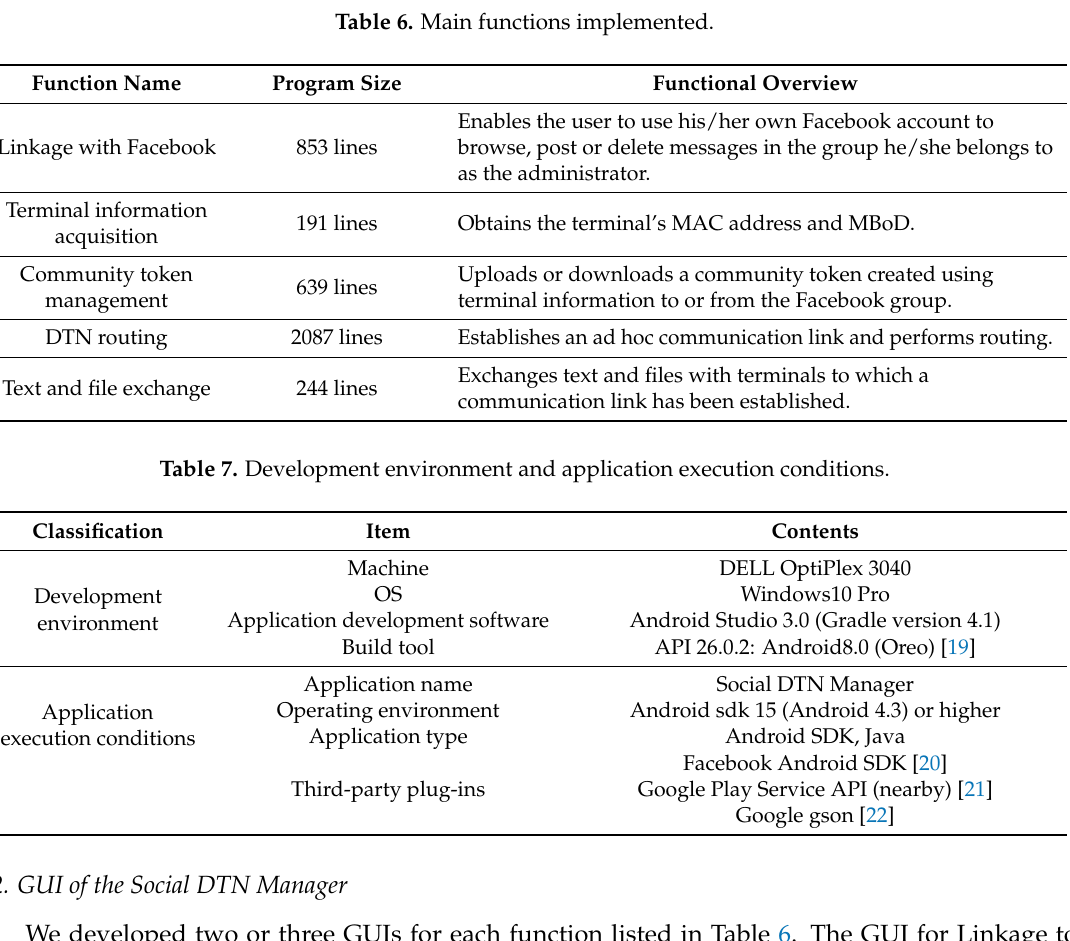
Table 6. Main functions implemented.